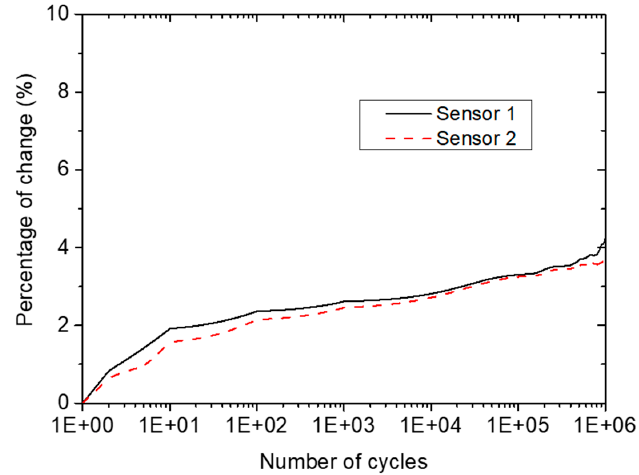
Figure 7. Percentage change in signal maximum amplitude versus number of fatigue cycles.